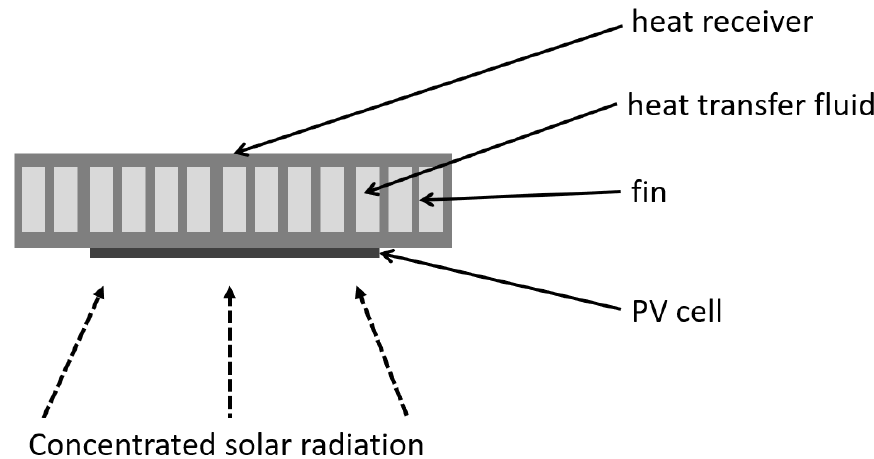
Figure 27. The cross-sectional view of a heat receiver with single-layer of microchannels.